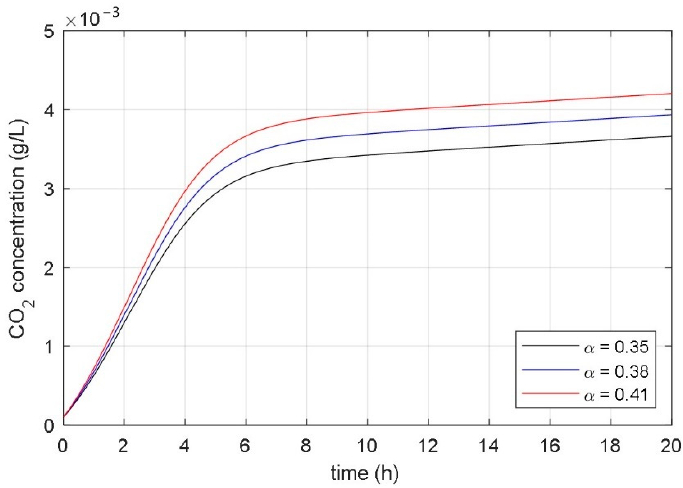
Figure 7. The impact of the substrate inhibition constant S i on the time course of the CO 2 concentra- tion.